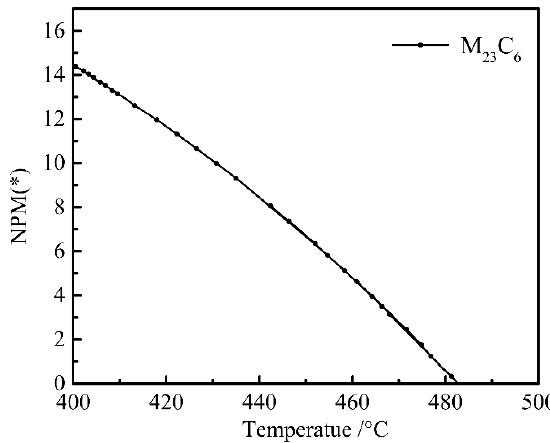
Figure 6. Plot of M 23 C 6 content (wt%) versus temperature.